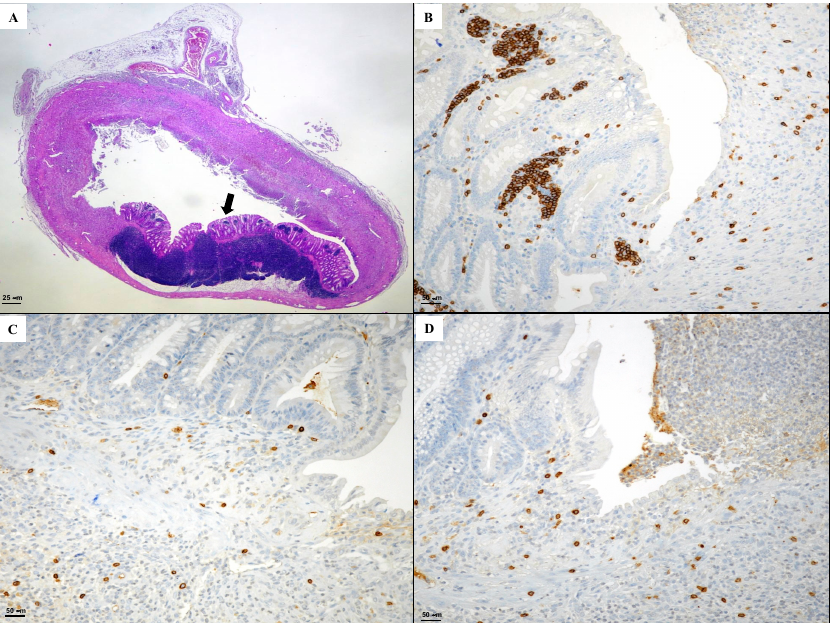
Figure 9. ( A ) Representative H&E images (original magnification ×10) ( B ) CD3, ( C ) CD20, ( D ) CD44 immunostaining (original magnification ×20) of tissues derived from the DNBS + HA group. The arrow indicates the regenerated area.